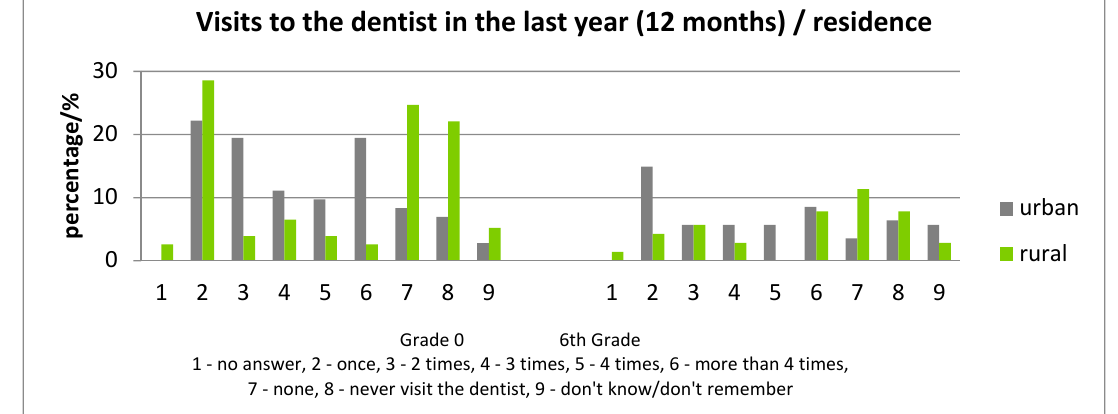
Figure 4. Differences of the number of visits in the dental office for the last year, according to Figure 4. Di ff erences of the number of visits in the dental o ffi ce for the last year, according to residence. residence. Table 5. Contribution to ICDAS score of the children who “never visited a